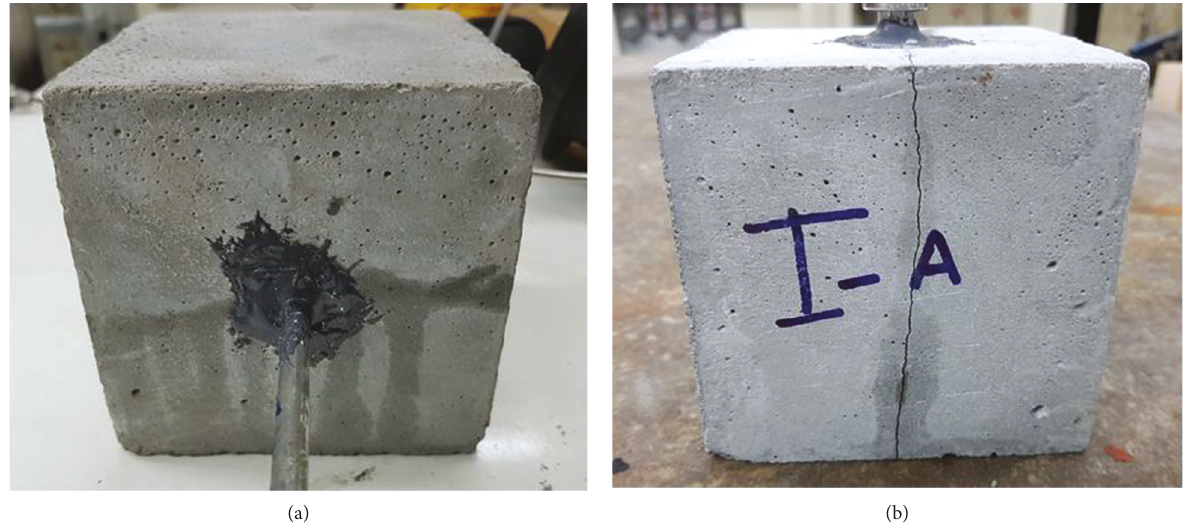
Figure 11: A view of cement sample 1/4-inch hole diameter (a) and 3/8-inch hole diameter (b) after fracturing with distilled water.